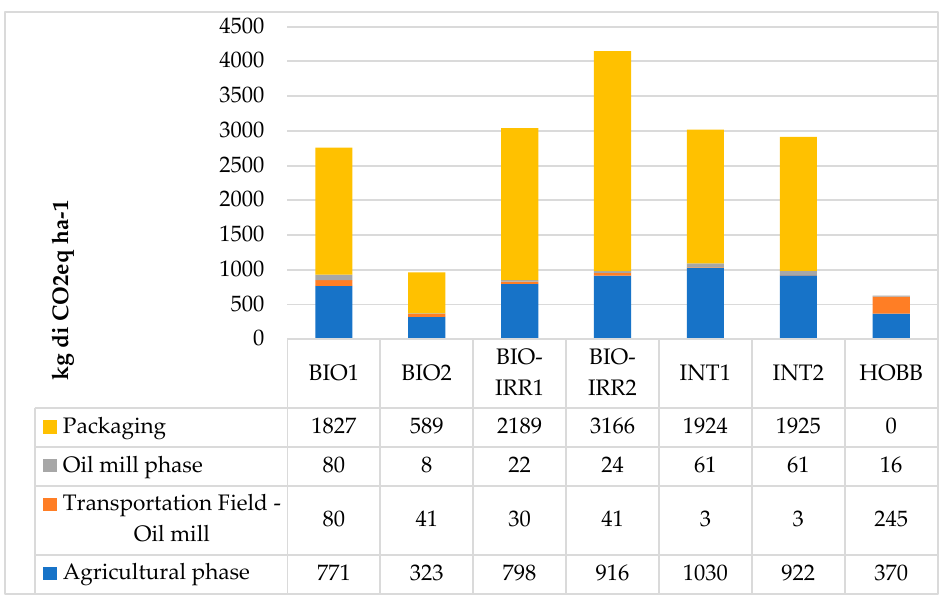
Figure 4. Global Warming per phase of the production process. Values per hectare.